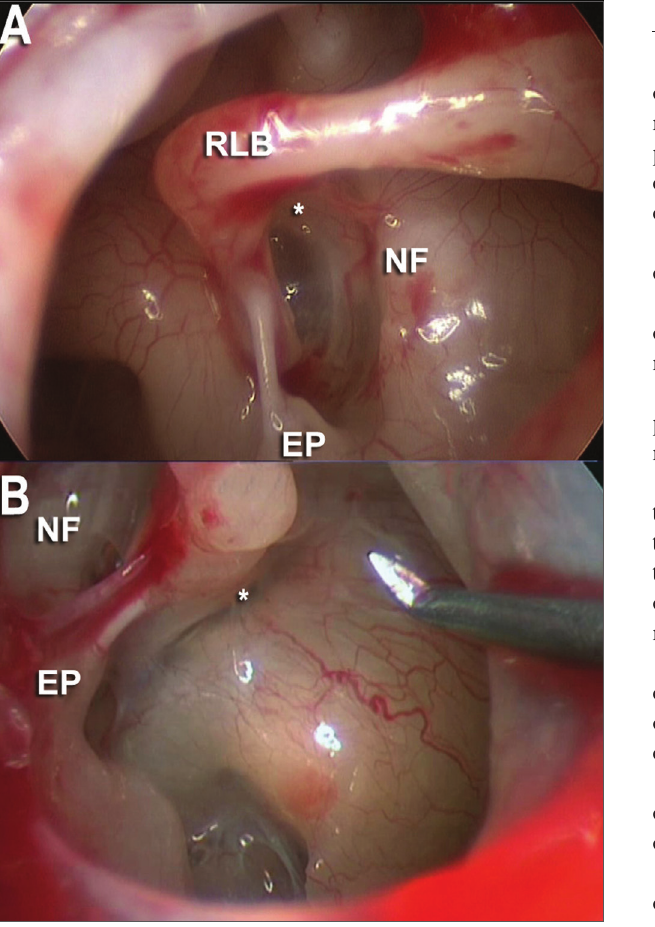
Figura 3. Visão endoscópica, com instrumento angulado com 30 graus, do nicho da janela oval. A: Evidencia-se o canal do nervo facial (NF), ramo longo da bigorna (RLB), eminência piramidal (EP) com seu tendão e o estribo com suas cruras posterior e anterior (*). B: Notamos em outro caso a mesma visão endoscópica, com instrumento com 30 graus de